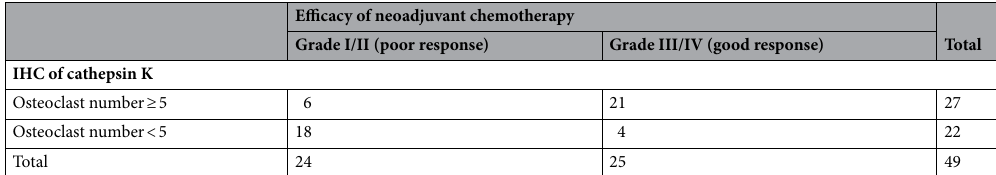
Table 4. Cross-classification of OS patients by IHC of CathepsinK and efficacy of neoadjuvant chemotherapy. OS : osteosarcoma, IHC : immunohistochemical staining.